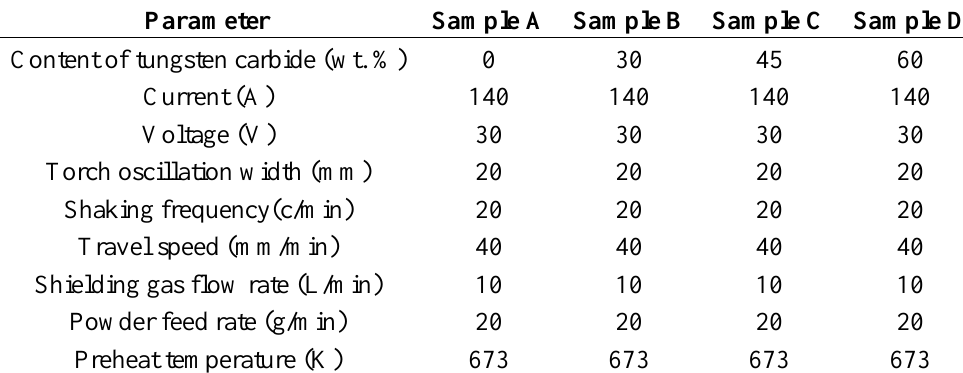
Table 2. Welding parameters of the plasma transfer arc welding